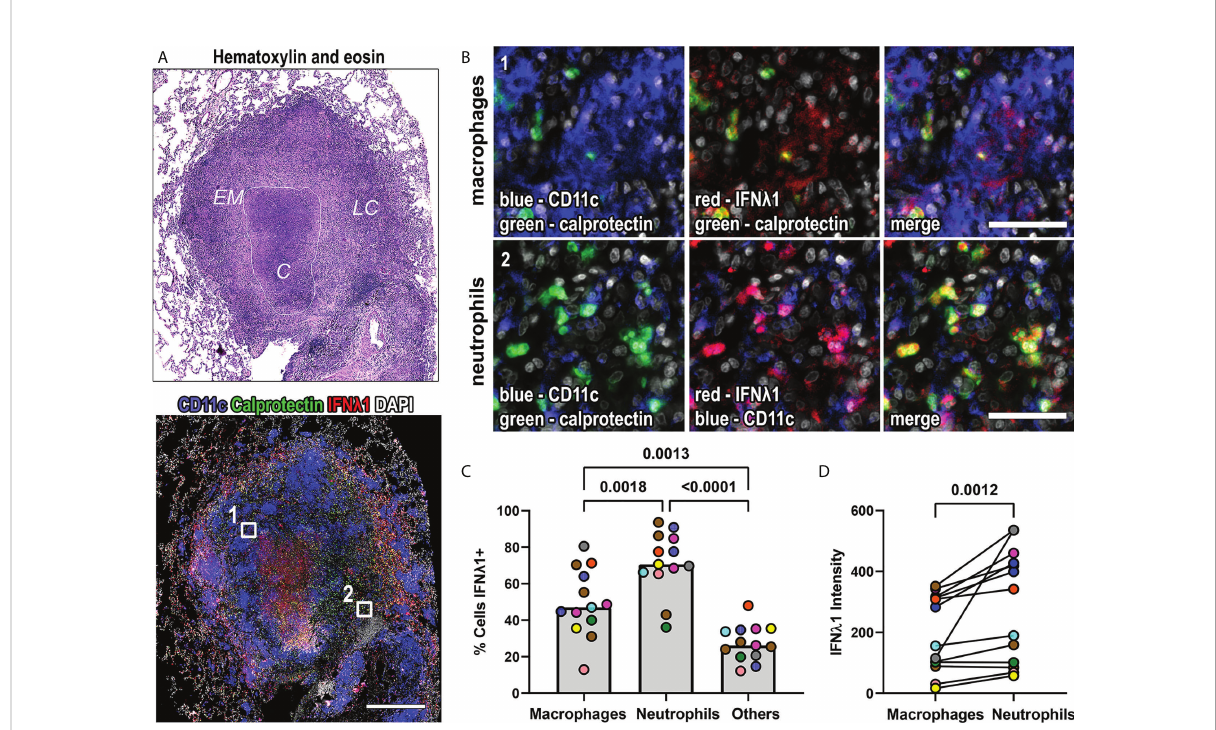
FIGURE 2 IFN l 1 is expressed in macrophages and neutrophils in granulomas. (A) A representative lung granuloma stained with hematoxylin and eosin (H&E; top left) to indicate the lymphocyte cuff ( LC ), epithelioid macrophage ( EM ), and caseous (C) regions and to detect IFN l 1 (red), CD11c+ macrophages (blue), and calprotectin+ neutrophils (green) (bottom left). Nuclei were stained with DAPI (grey). The white boxes in the immuno fl uorescence image indicate regions depicted in (B.). Scale bar represents 500 m m. (B) Region 1 shows IFN l 1 (red) expression in CD11c+ macrophages (blue). Region 2 shows IFN l 1 (red) expression in calprotectin+ neutrophils (green). Images acquired at 20x magni fi cation, scale bars represent 50 m m. (C) Percentage of CD11+ macrophages, calprotectin+ neutrophils, and other cells expressing IFN l 1 in granulomas (n=13). Median values for granuloma are shown where each marker color represents an animal. Statistical comparison by Tukey ’ s multiple comparisons test. (D) IFN l 1 expression, as measured by median fl uorescence intensity, by CD11c+ macrophages and calprotectin+ neutrophils (n=13 granulomas). Each point depicts the median intensity values for macrophages or neutrophils per granuloma, with each marker ’ s color representing a different animal. Statistical comparison by Wilcoxon matched-pairs signed rank